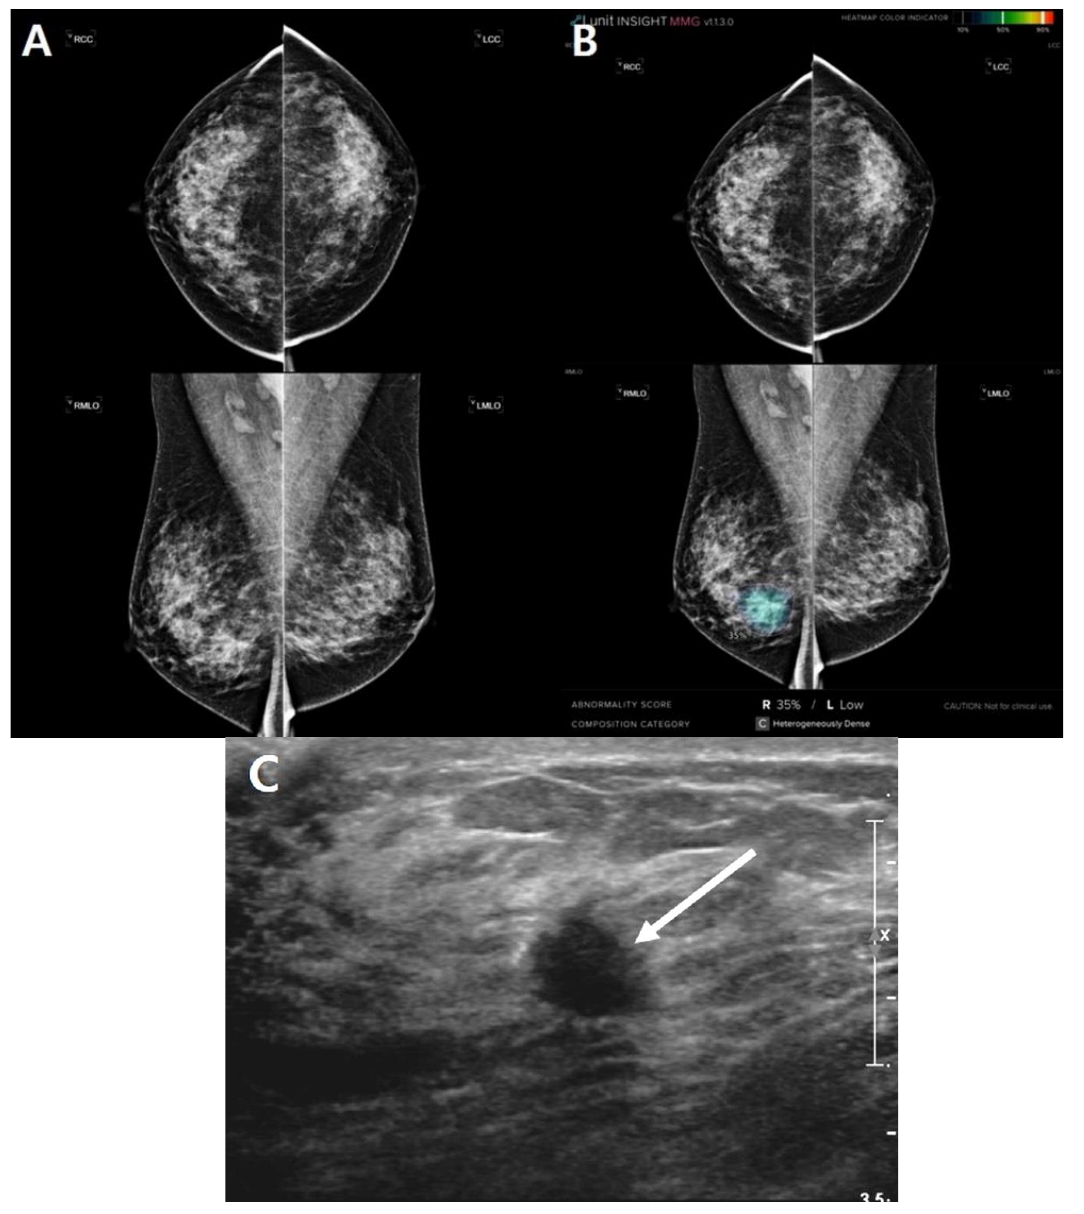
Figure 2. An invisible case in radiologist ’s analysis that is concordant only in AI analysis. A 49-year-old woman had a breast checkup. ( A ) Mammography revealed a dense breast without